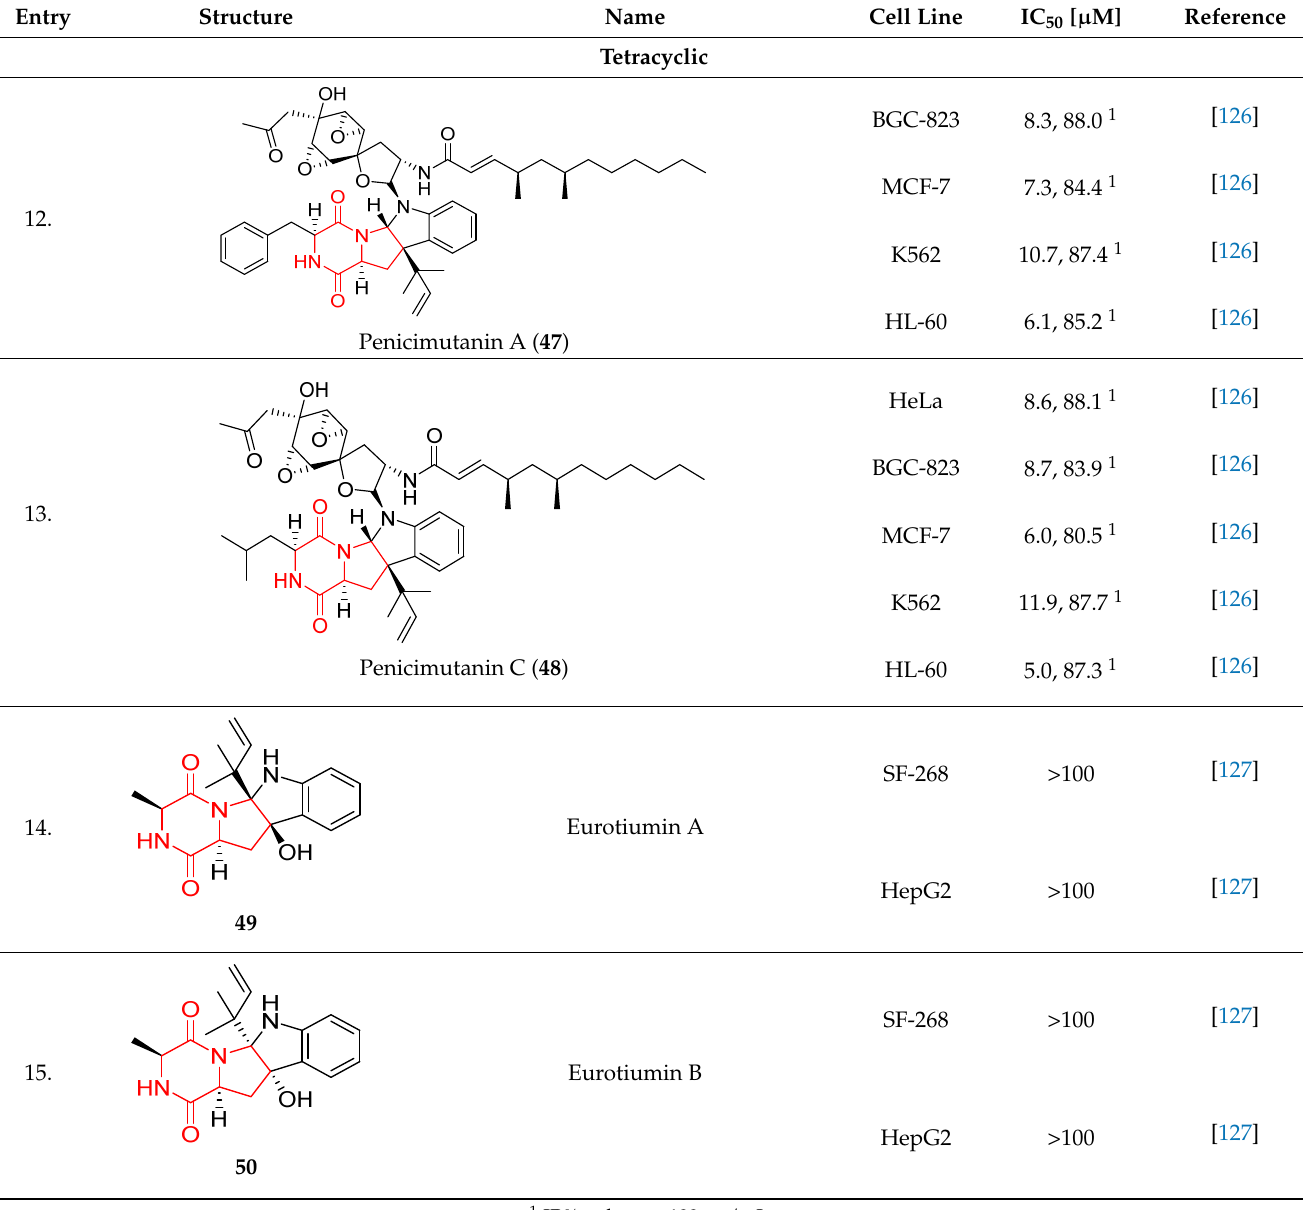
50 1 IR% values at 100 μ g/mL. Yu reported the isolation of tetracyclic okaramine C ( 37 ) and okaramine G ( 38 ) from Yu reported the isolation of tetracyclic okaramine C ( 37 ) and okaramine G ( 38 ) from Yu reported the isolation of tetracyclic okaramine C ( 37 ) and okaramine G ( 38 ) from coprophilous fungus Aphanoascus fulvescens and tested them for cytotoxic effect on L5178Y coprophilous fungus Aphanoascus fulvescens and tested them for cytotoxic effect on L5178Y coprophilous fungus Aphanoascus fulvescens and tested them for cytotoxic effect on L5178Y (mouse lymphoma) cell line (Table 3, entries 4,5) [123]. Compounds 37 and 38 showed (mouse lymphoma) cell line (Table 3, entries 4,5) [123]. Compounds 37 and 38 showed (mouse lymphoma) cell line (Table 3, entries 4,5) [123]. Compounds 37 and 38 showed significant cytotoxicity with IC 50 values of 14.7 and 12.8 μ M, respectively. Cai described significant cytotoxicity with IC 50 values of 14.7 and 12.8 μ M, respectively. Cai described significant cytotoxicity with IC 50 values of 14.7 and 12.8 μ M, respectively. Cai described novel Okaramines S ‐ U, isolated from Aspergillus taichungensis ZHN ‐ 7 ‐ 07, diprenylated novel Okaramines S ‐ U, isolated from Aspergillus taichungensis ZHN ‐ 7 ‐ 07, diprenylated novel Okaramines S ‐ U, isolated from Aspergillus taichungensis ZHN ‐ 7 ‐ 07, diprenylated Okaramine S ( 39 ), monoprenylated Okaramine T ( 40 ) and Okaramine U ( 41 ) deprived of Okaramine S ( 39 ), monoprenylated Okaramine T ( 40 ) and Okaramine U ( 41 ) deprived of Okaramine S ( 39 ), monoprenylated Okaramine T ( 40 ) and Okaramine U ( 41 ) deprived of prenyl groups (Table 3, entry 6) [124]. In the cytotoxic evaluation, only diprenylated prenyl groups (Table 3, entry 6) [124]. In the cytotoxic evaluation, only diprenylated prenyl groups (Table 3, entry 6) [124]. In the cytotoxic evaluation, only diprenylated Okaramine S ( 39 ) exhibited a promising effect on HL ‐ 60 and K562 cell lines with IC 50 values of 0.78 and 22.4 μ M, respectively. Roquefortine F ( 42 ) and Roquefortine G ( 43 ) were Okaramine S ( 39 ) exhibited a promising effect on HL ‐ 60 and K562 cell lines with IC 50 Okaramine S ( 39 ) exhibited a promising effect on HL ‐ 60 and K562 cell lines with IC 50 values of 0.78 and 22.4 μ M, respectively. Roquefortine F ( 42 ) and Roquefortine G ( 43 ) were isolated from a deep ocean sediment derived fungus Penicillium sp. and tested on four cell values of 0.78 and 22.4 μ M, respectively. Roquefortine F ( 42 ) and Roquefortine G ( 43 ) were values of 0.78 and 22.4 μ M, respectively. Roquefortine F ( 42 ) and Roquefortine G ( 43 ) were isolated from a deep ocean sediment derived fungus Penicillium sp. and tested on four cell lines: A ‐ 549, HL ‐ 60, BEL ‐ 7402, MOLT ‐ 4 (Table 3, entries 7,8) [125]. Roquefortine F ( 42 ), the isolated from a deep ocean sediment derived fungus Penicillium sp. and tested on four cell isolated from a deep ocean sediment derived fungus Penicillium sp. and tested on four cell lines: A ‐ 549, HL ‐ 60, BEL ‐ 7402, MOLT ‐ 4 (Table 3, entries 7,8) [125]. Roquefortine F ( 42 ), the more cytotoxic derivative, showed moderate effect with IC 50 values of 14.0, 33.6, 13.0, and four cell lines: A-549, HL-60, BEL-7402, MOLT-4 (Table 3, entries 7,8) [125]. lines: A ‐ 549, HL ‐ 60, BEL ‐ 7402, MOLT ‐ 4 (Table 3, entries 7,8) [125]. Roquefortine F ( 42 ), the lines: A ‐ 549, HL ‐ 60, BEL ‐ 7402, MOLT ‐ 4 (Table 3, entries 7,8) [125]. Roquefortine F ( 42 ), the more cytotoxic derivative, showed moderate effect with IC 50 values of 14.0, 33.6, 13.0, and more cytotoxic derivative, showed moderate effect with IC 50 values of 14.0, 33.6, 13.0, and more cytotoxic derivative, showed moderate effect with IC 50 values of 14.0, 33.6, 13.0, and